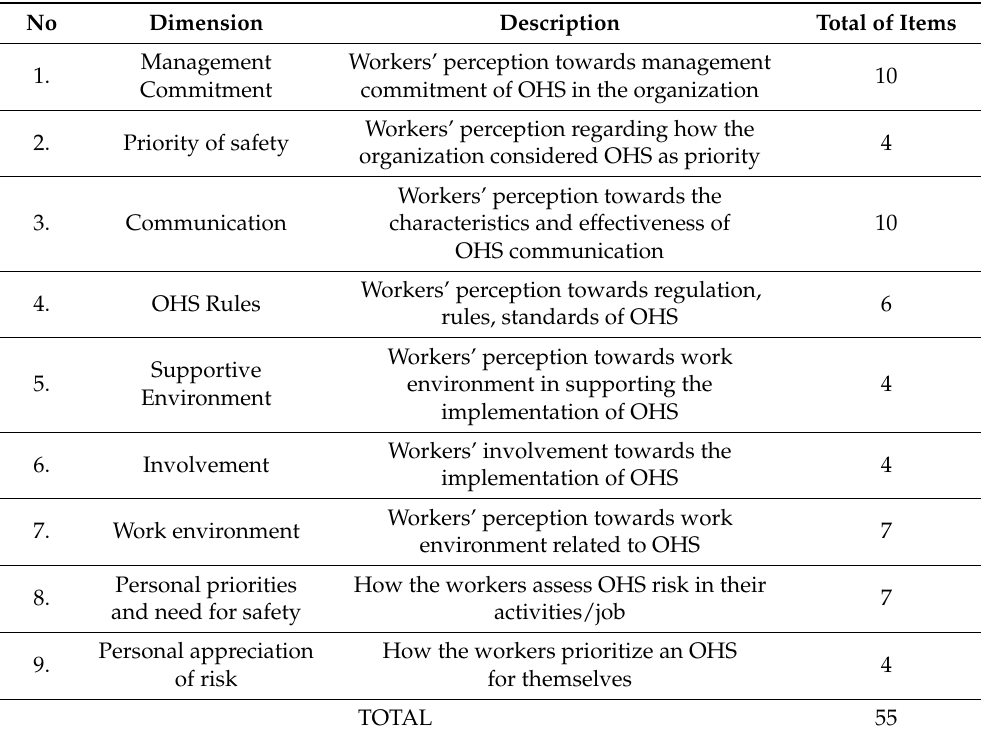
Table 2. Safety climates dimension